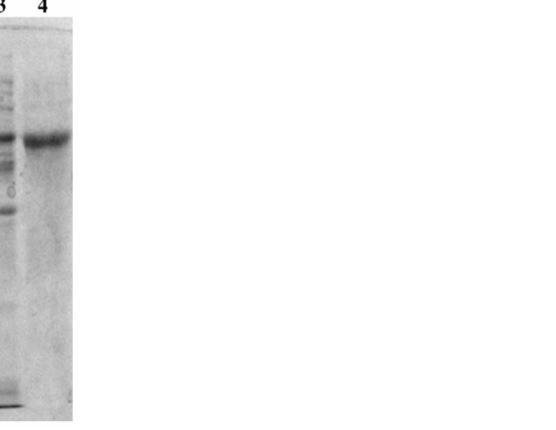
Figure 3. SDS-PAGE of purified recombinant proteins. ( Lane M ). Standard protein Marker; ( Lane 1 ). GME3292-pET28a (+) cell disruption supernatant; ( Lane 2 ). reFAE1 enzyme solution after purification; ( Lane 3 ). GME11122-pET28a (+) cell disruption supernatant; ( Lane 4 ). reFAE2 enzyme solution after